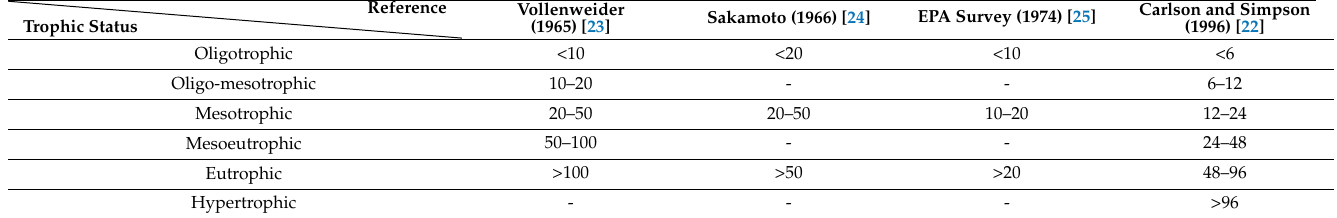
Table 3. Classification of the trophic status of reservoirs based on the Carlson index in terms of phosphorus concentration (TSI P )